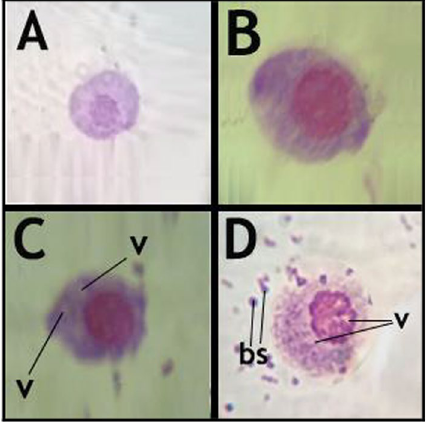
Fig. 7 Morphological changes in plasmatocytes ( x (normal larvae), B F1 larvae (from irradiated male parent pupae with 100 Gy). C larvae feed on treated leaves with LC 50 , D F1 larvae feed on treated leaves with LC 50 . v: vacuole, bs: M. anisopliae